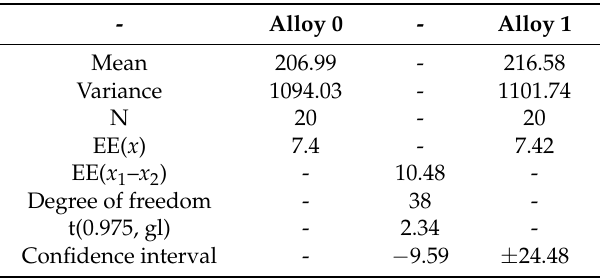
Table 3. Contrast of hypothesis for alloy 0 and alloy 1.